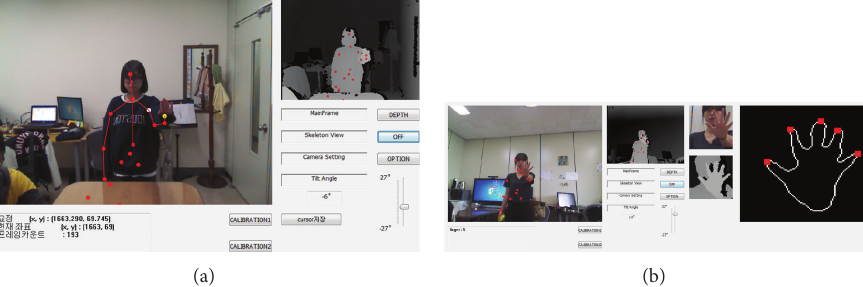
Figure11:Lab-madegesturerecognitionsoftwarebasedontheupperbodyskeletonmodelintheKinectSDK.(a)Pointinggesturerecognition software (white dot: shoulder point, yellow dot: hand point) [10]. (b) Finger counting gesture recognition software.